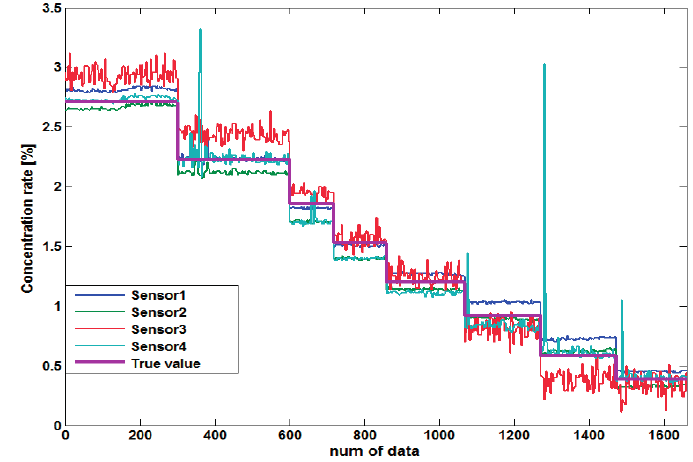
Figure 7. Concentration value acquired by four sensors.